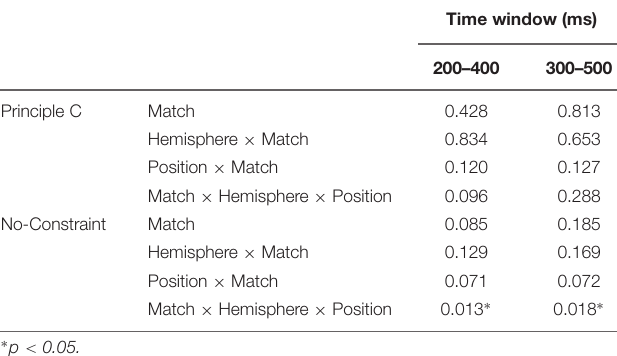
TABLE 2 | Simple interactions follow-up.